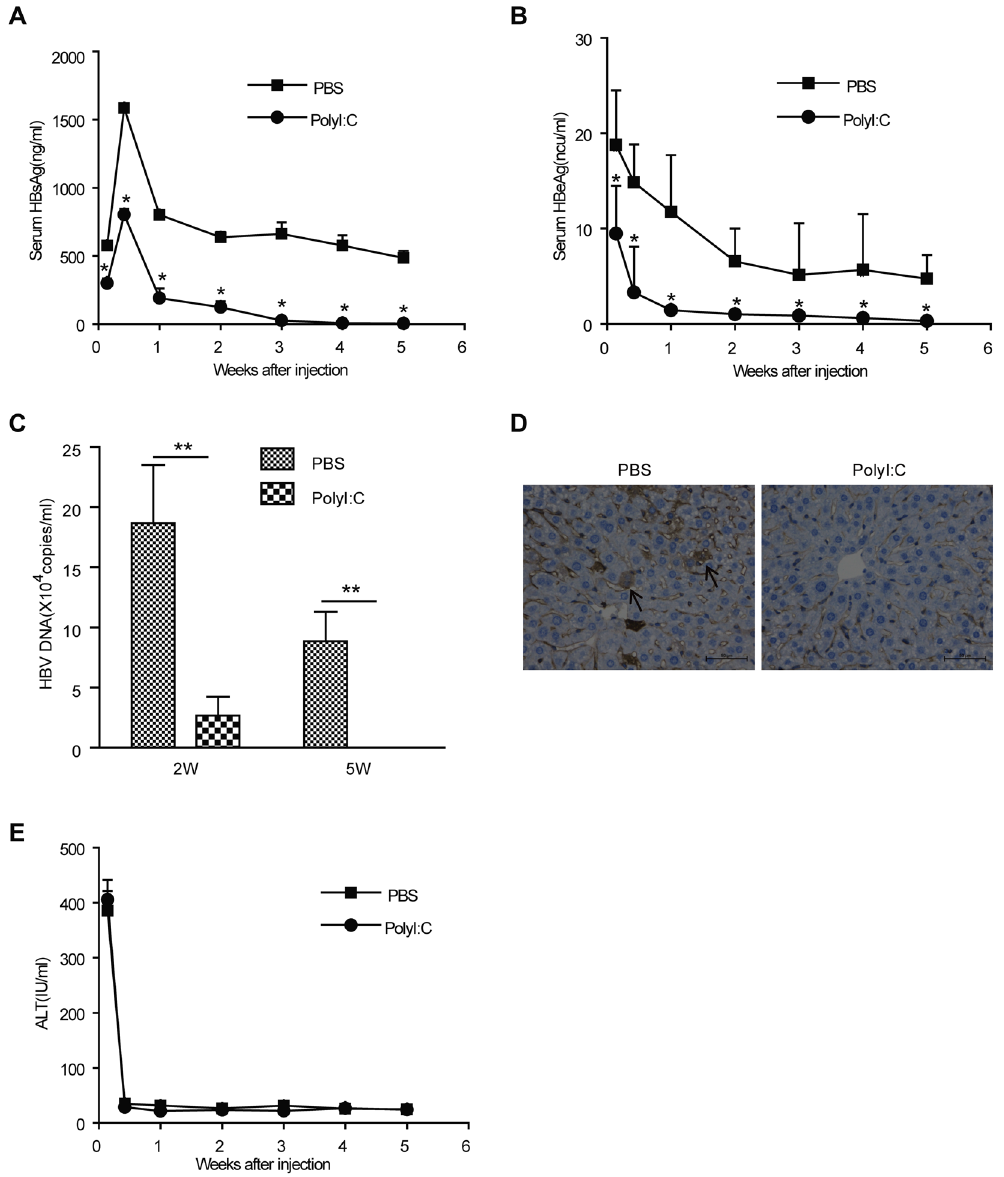
Figure 3. Early PolyI:C treatment prevents HBV persistence in the HBV mouse model. C57BL/6 mice were injected with HBV plasmid and chronically treated with Poly I:C as described in Materials and Methods. Titers of serum HBsAg ( A ), HBeAg ( B ), HBV DNA ( C ), and ALT ( E ) were determined at indicated time points. ( D ) At 5 weeks post injection, Livers were processed for HBcAg expression (original magnification, x100). Data are shown as mean ± SEM; * p < 0.05, ** p < 0.01. n = 6–8 in each